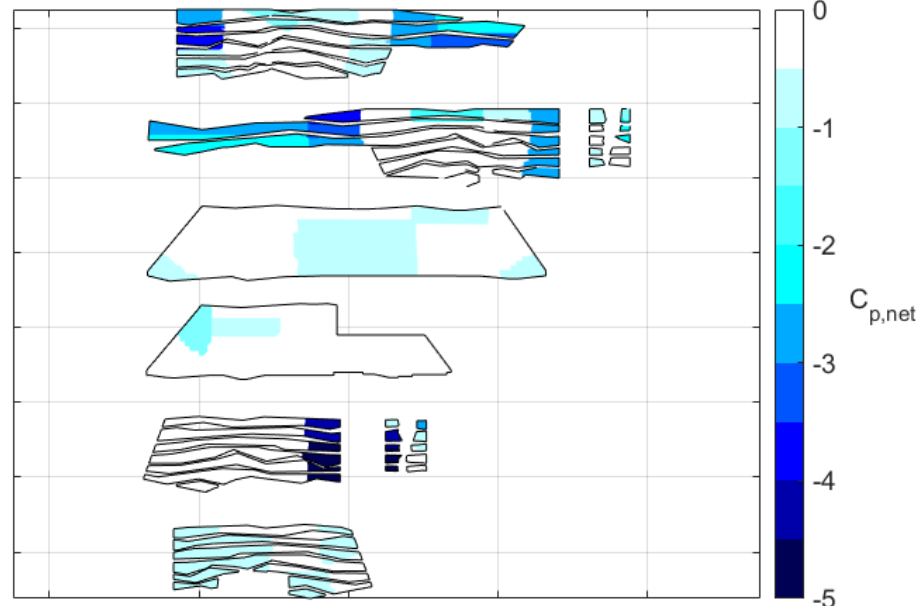
Figure 20. Envelope maps of the negative ˇ C p , net , measured on the porous façade of the